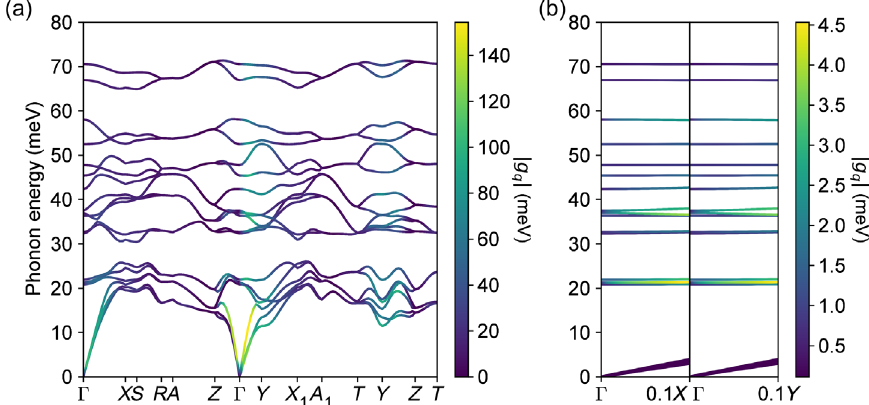
FIG. 4. (a) Calculated phonon dispersion of WP 2 . The effective normalized phonon-electron matrix element is projected onto each phonon mode ( q , ω ). The acoustic phonon modes have much stronger coupling than the optical modes. However, when comparing different optical modes, the lower-energy modes A 1 ð 1 Þ and A 1 ð 2 Þ show a significant enhancement of phonon-electron coupling compared to that of the higher-energy ones. (b) Close-up view of the phonon-electron coupling strength for small q near Γ , highlighting the largely enhanced coupling strength at finite q . Only the optical modes are colored according to coupling for